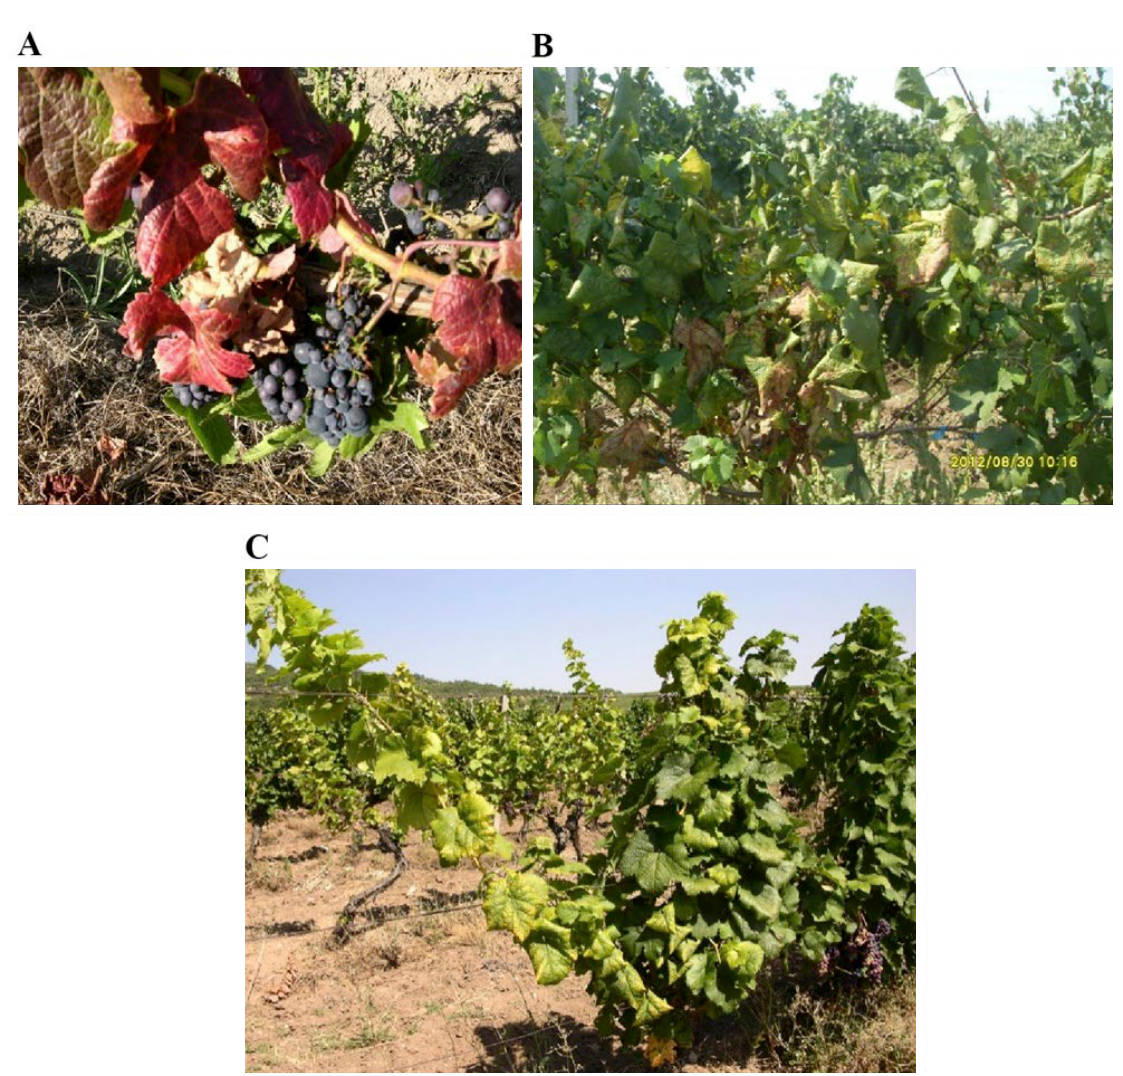
Figure 1. Grapevine yellows symptoms observed on Vranec (A), Chardonnay (B) and Stanusina (C) grapevine varieties. Vranec and Chardonnay showed typical grapevine yellows symptoms, while Stanusina (red grape variety) exhibited white variety-like